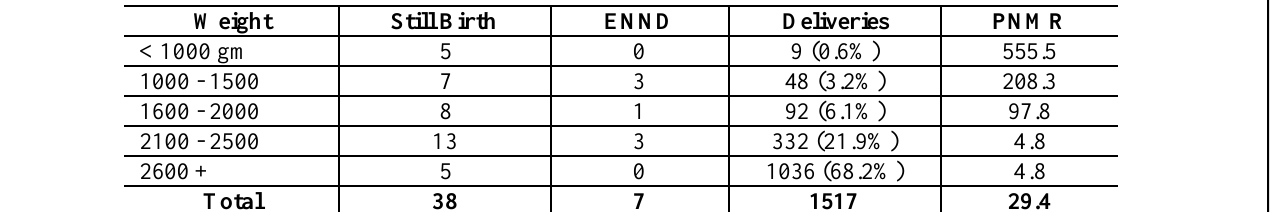
Table II : The Relation of Perinatal Death To Birth Weight